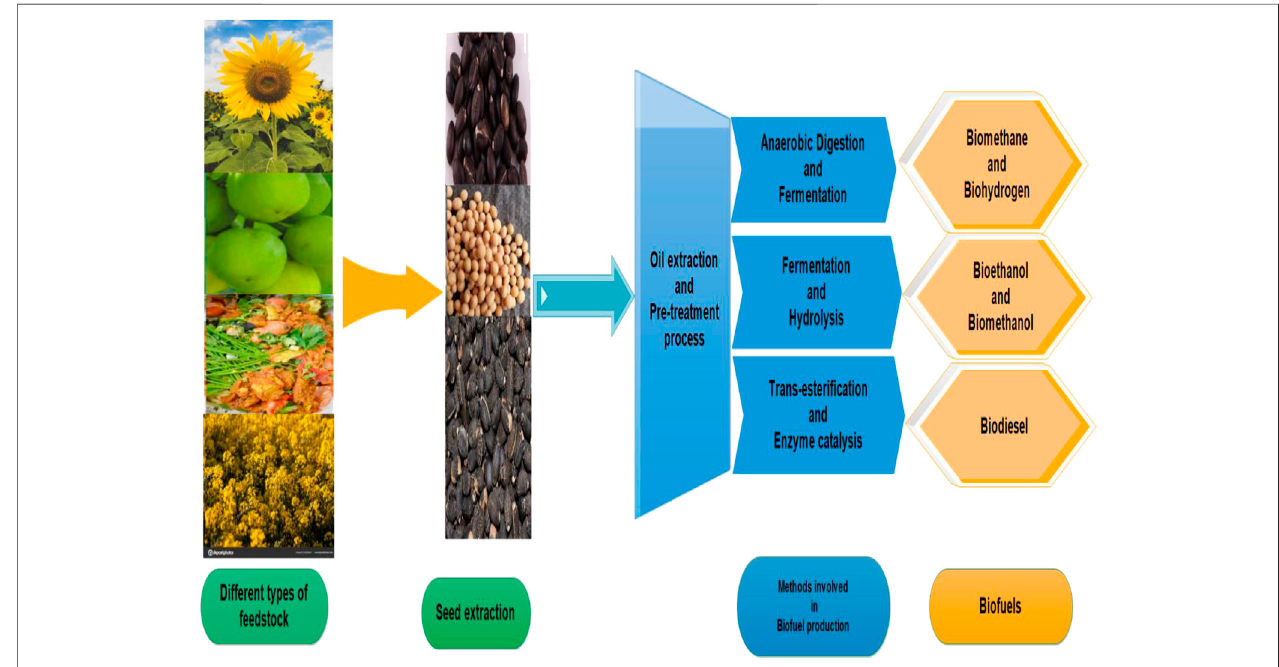
FIGURE 1 | Different stages of biofuel